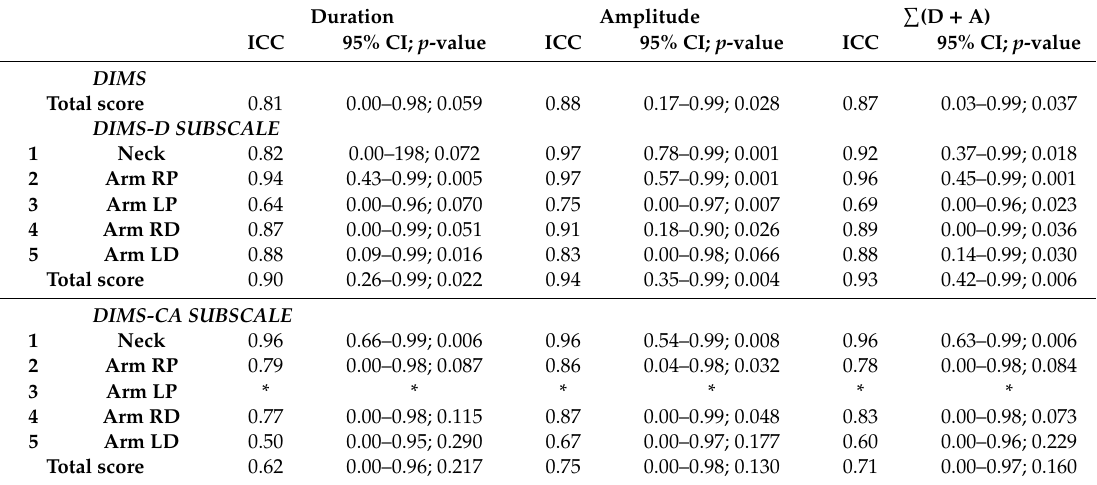
Table A3. Test–retest reliability: Intraclass correlation coe ffi cients (ICC) with 95% confidence interval (CI) between two measuring weeks for the Dyskinesia Impairment Mobility Scale, with excluded left arm proximal scores for the DIMS-CA